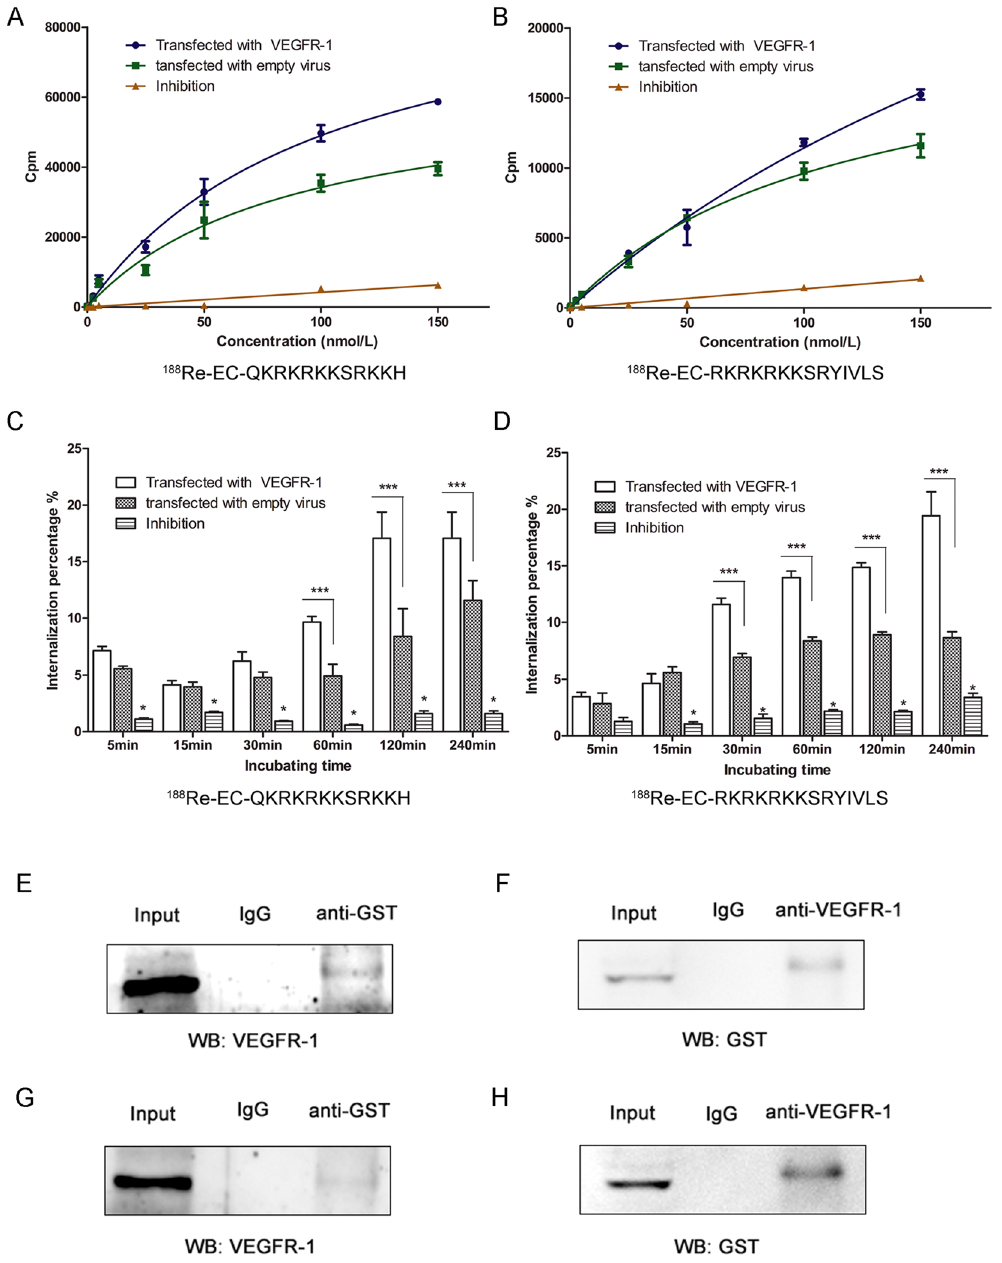
Figure 4. Binding assay between peptide and VEGFR-1. Receptor saturation binding assays ( A , B ) and internalization assays ( C , D ) of the 188 Re-labeled peptides. VEGFR-1-overexpressing A549 cells displayed more abundant binding of the radiolabeled peptides and a higher internalization rate compared with the control cells. The inhibited group was compared with the other two groups at each time point. * P < 0.01; *** P < 0.001. ( E , F ) Co-immunoprecipitation of GST-QKRKRKKSRKKH and VEGFR-1; ( G , H ): Co-immunoprecipitation of GST- RKRKRKKSRYIVLS and